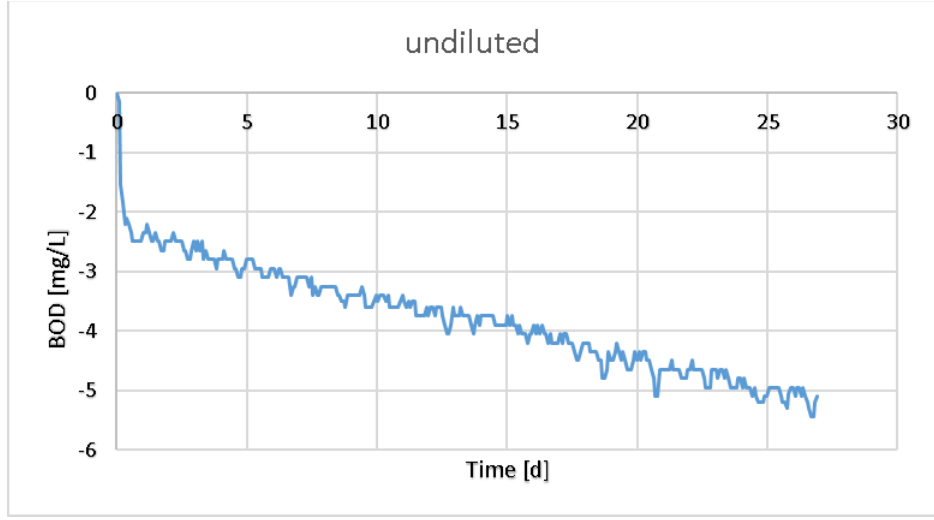
Figure 1. BOD value of the raw WWP1 sample measured with BOD OxiTop for 28 days.